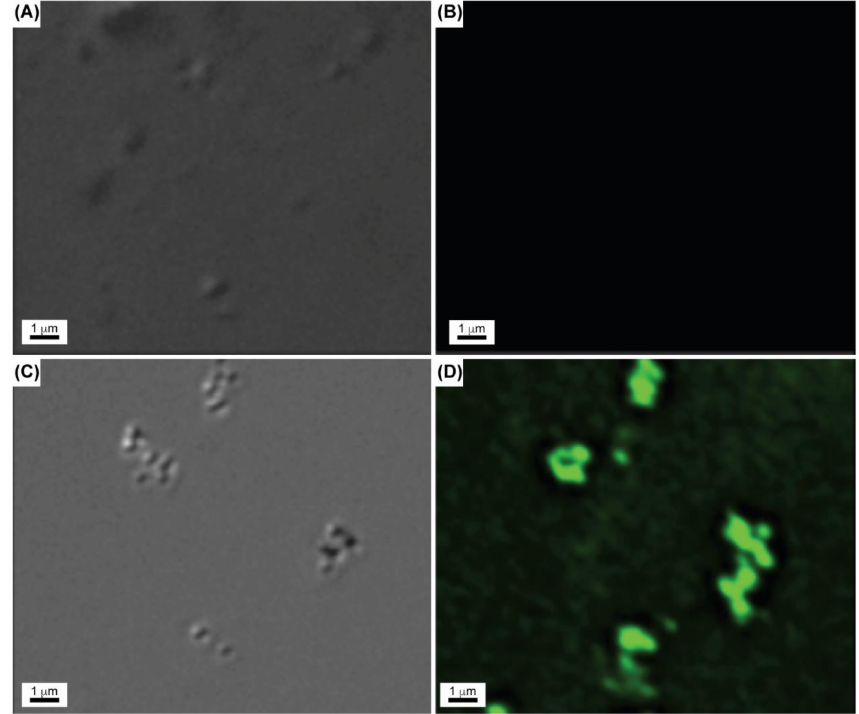
Figure 7. Confocal microscope images of: ( A ) control experiment in normal brightfield mode; ( B ) control experiment in fluorescence mode; ( C ) avidin-nanoparticles complexed with biotin-4-FITC in normal brightfield mode; and ( D ) avidin-nanoparticles complexed with biotin-4-FITC in fluorescence